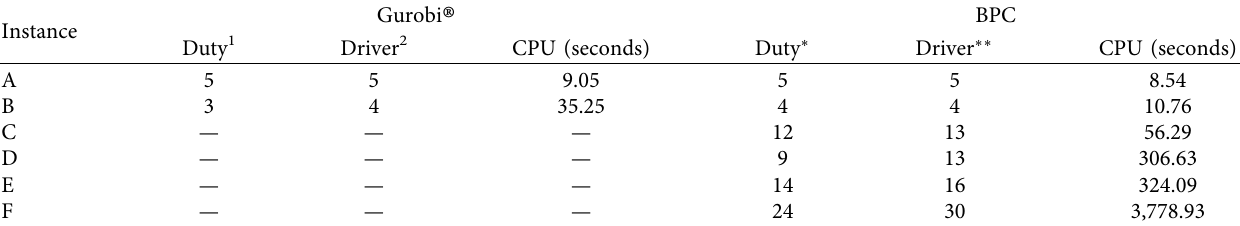
Table 2: The comparison between the Gurobi ® package and the BPC